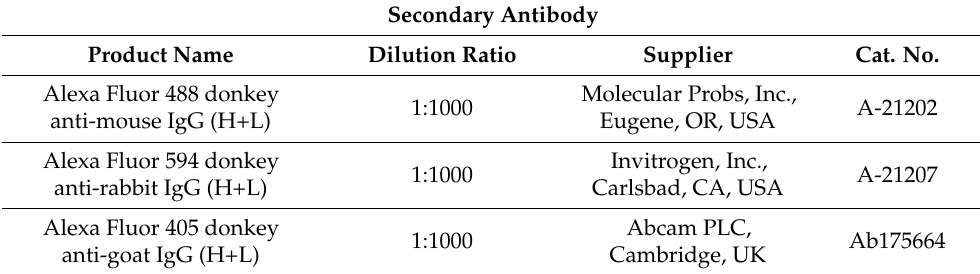
Table 2. Secondary antibodies used for immunohistochemistry